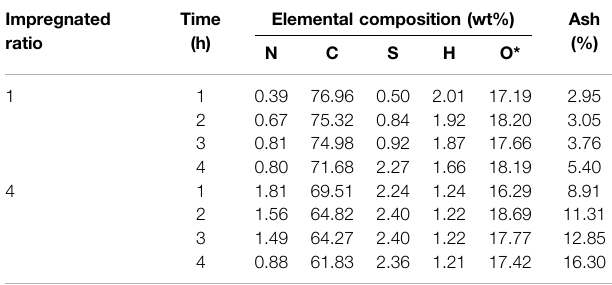
Elemental composition